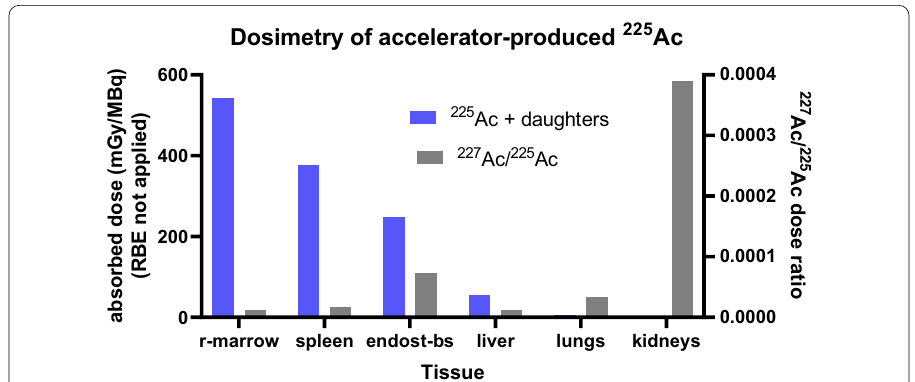
Fig. 6 Total absorbed dose to tissue from 1 MBq administration of 225/7 Ac-labeled anti-CD33 antibody in patients with leukemia. The left axis gives the absorbed dose (blue bars) from 225 Ac and all daughters. The right axis is the 227 Ac to 225 Ac absorbed dose (including daughters) ratio (grey